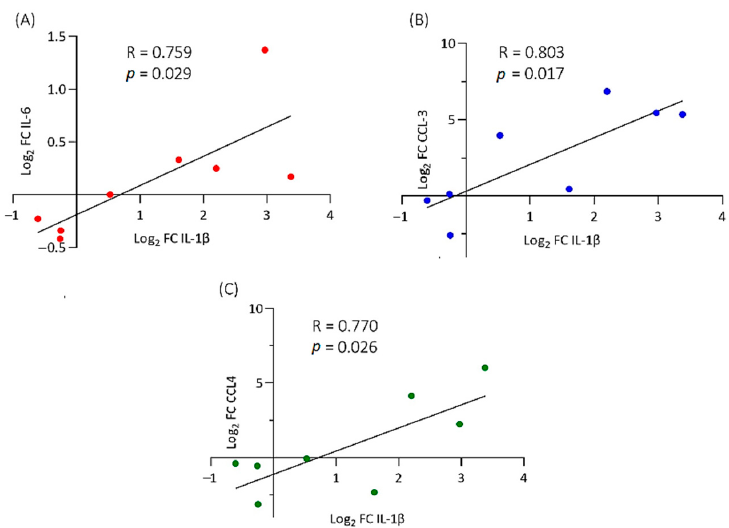
Figure 5. Statistically significant correlation between IL-1 β and IL-6 ( A ), CCL3 ( B ) and CCL4 ( C ) gene expression [Fold change (FC)] after 3 h infection (MOI = 1:1000). Data represent eight donor cell samples.